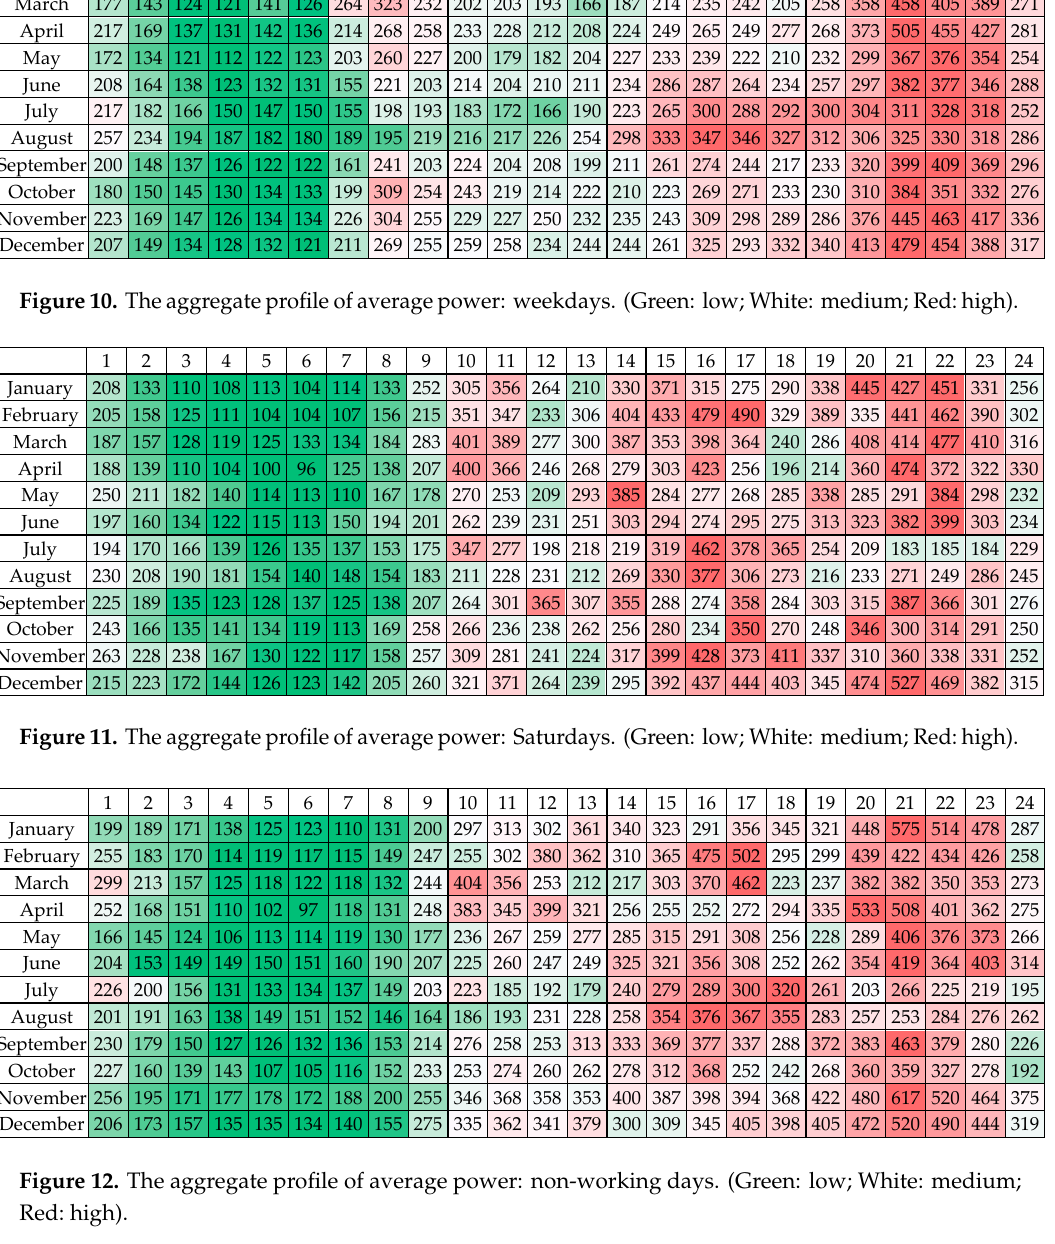
Figure 10. The aggregate profile of average power: weekdays. (Green: low; White: medium; Red: high).